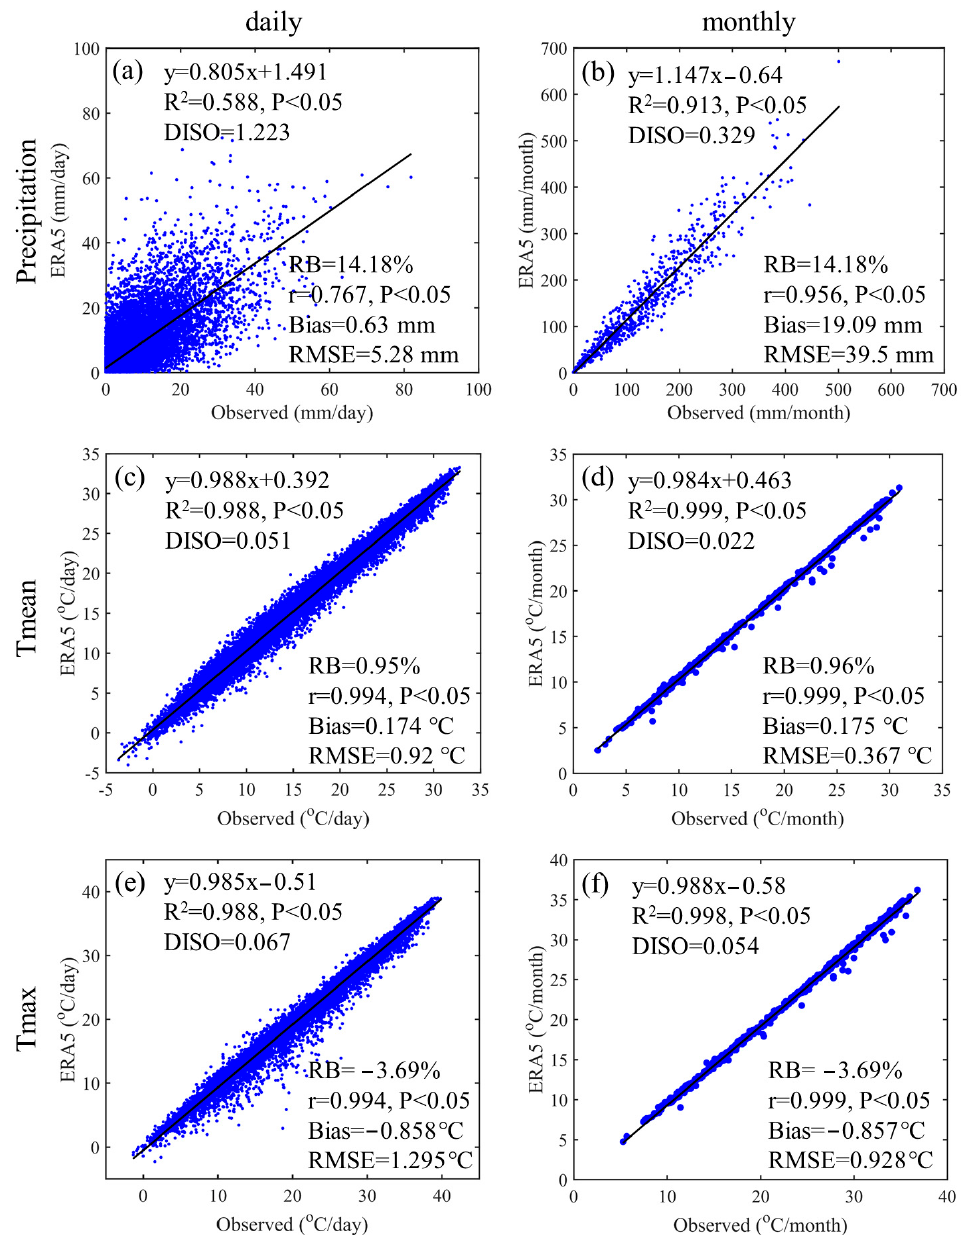
Figure 2. Scatter plots of ( a , b ) precipitation, ( c , d ) T mean , and ( e , f ) T max from the ERA5 against the observations averaged GRB from 1961 to 2018. The left and right columns represent the daily and monthly values, respectively.